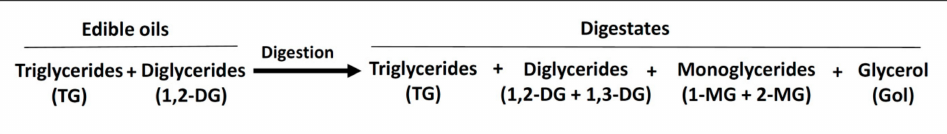
Figure 4. Usual lipolytic changes during digestion of edible